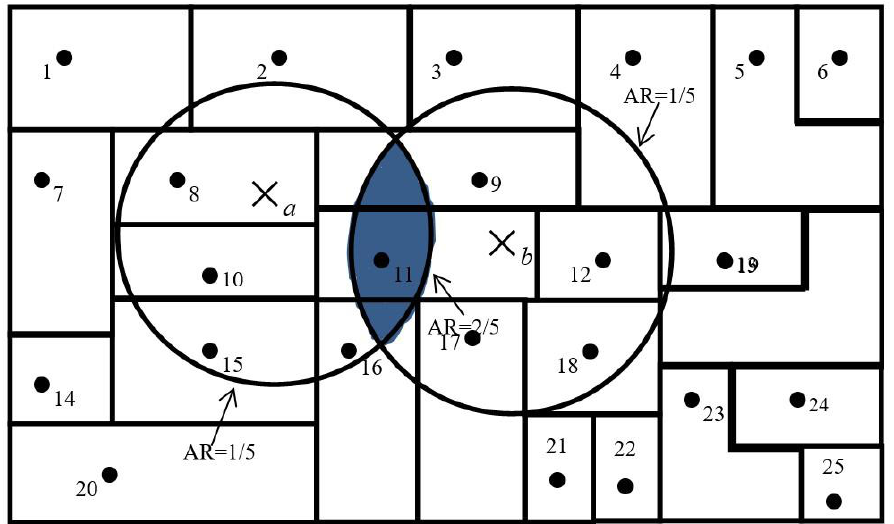
Figure 3. A simplified version of the two-step floating catchment area (2SFCA) method. AR = accessibility ratio.